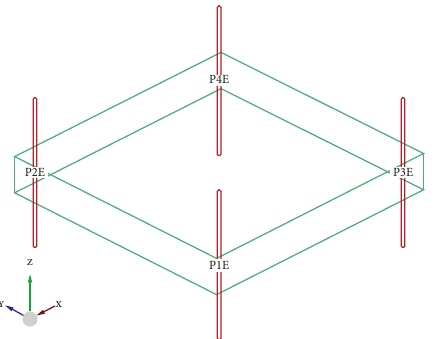
Figure 13: Simulation design of a dipole antenna array [43].